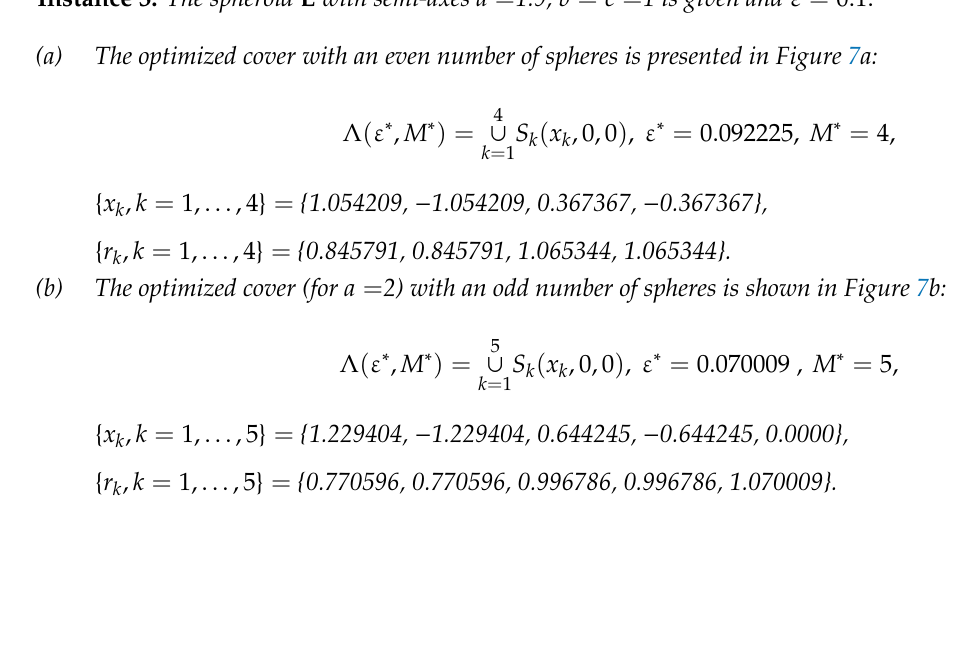
Instance 3. The spheroid E with semi-axes a = 1.9, b = c = 1 is given and ε = 0.1.